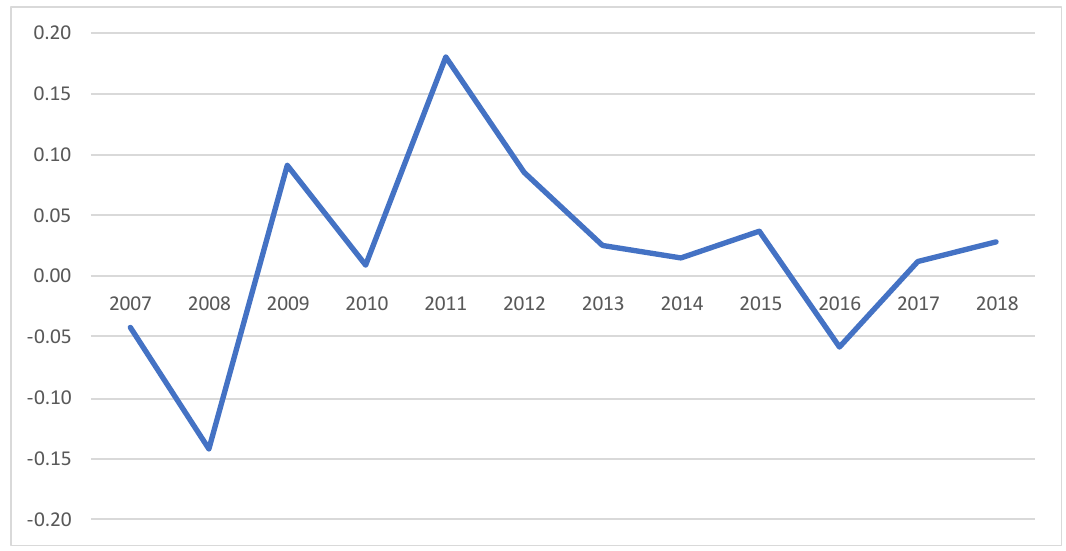
Figure 4. CML’s return on assets ratio (ROA) (2007 – 2018).